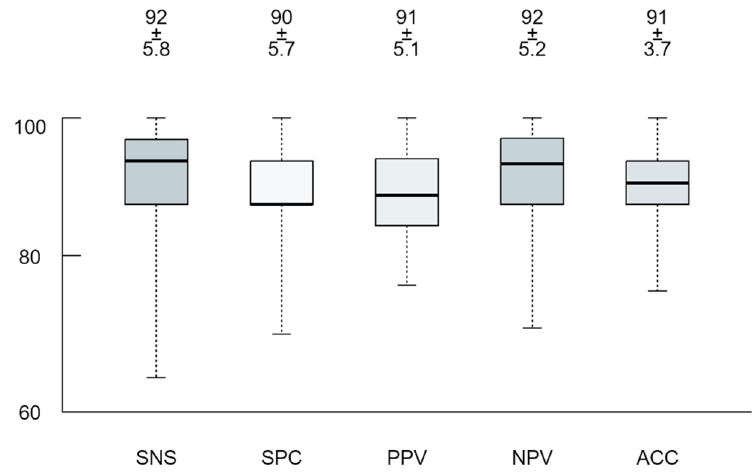
Figure 1. Box-plot Monte Carlo (MC) cross-validation performance of the established model scheme throughout the performance of the top-layer prediction model. Performance values were determined by confusion matrix analytics across all MC folds. SNS—Sensitivity; SPC—Specificity; PPV—Positive Predictive Value; NPV—Negative Predictive Value; ACC—Accuracy; Performance values.